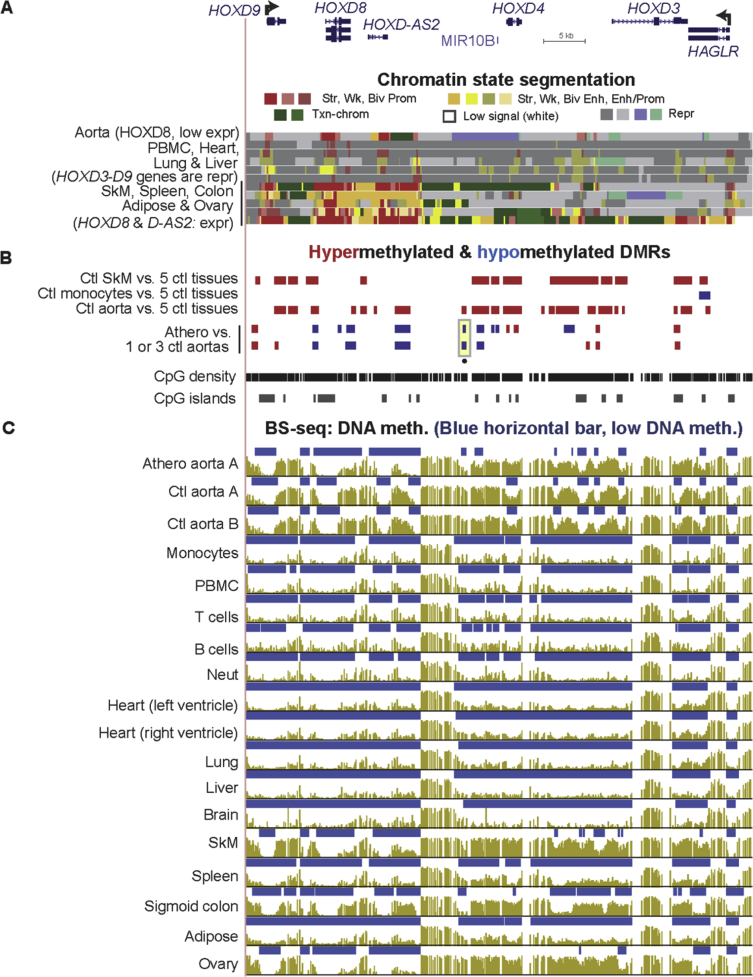
The HOXD gene cluster displays many subregions exhibiting atherosclerosis-associated DNA hypermethylation or hypomethylation. (A) RefSeq gene isoforms and chromatin state segmentation (chr2:176,984,957-177,045,568). (B) Tissue-specific and atherosclerosis-associated DMRs. (C) Bisulfite-seq DNA methylation profiles. Note that the athero hypermeth DMRs are in regions of low leukocyte DNA methylation and, thus, cannot be explained by monocyte infiltration.